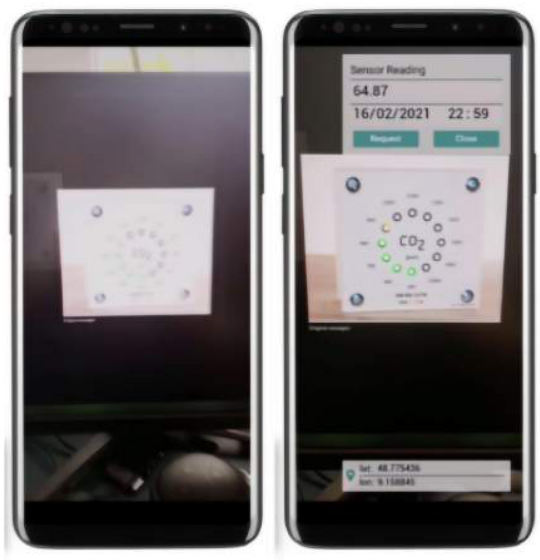
Figure 5. AR Application for Sensor reading